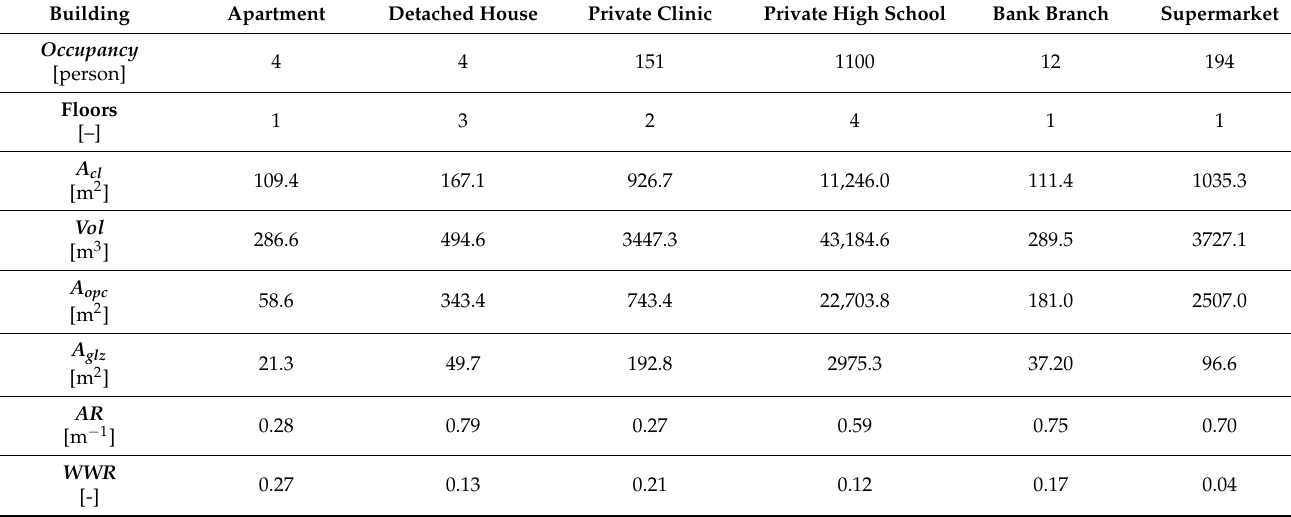
Table 5. Summary of the characteristics of the six buildings considered.